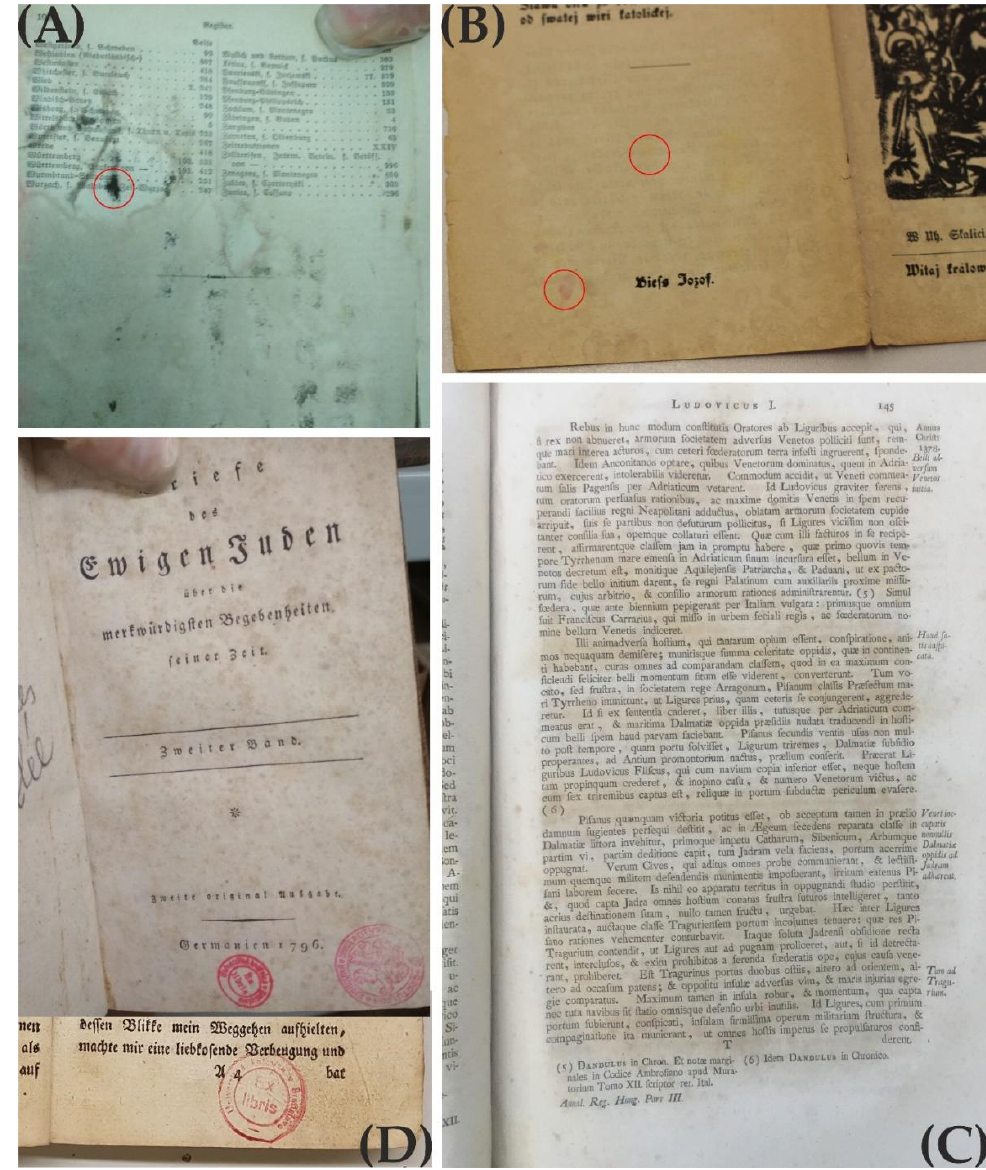
Figure 1. Several types of stains on the paper surface. ( A ) red circle, probably black fungal stains; many black spots are spread on the book page. ( B ) red circles showing presumable yellowish and pinkish fungal spots. ( C ) the phenomenon of foxing. ( D ) colored stamps on the books’ pages.